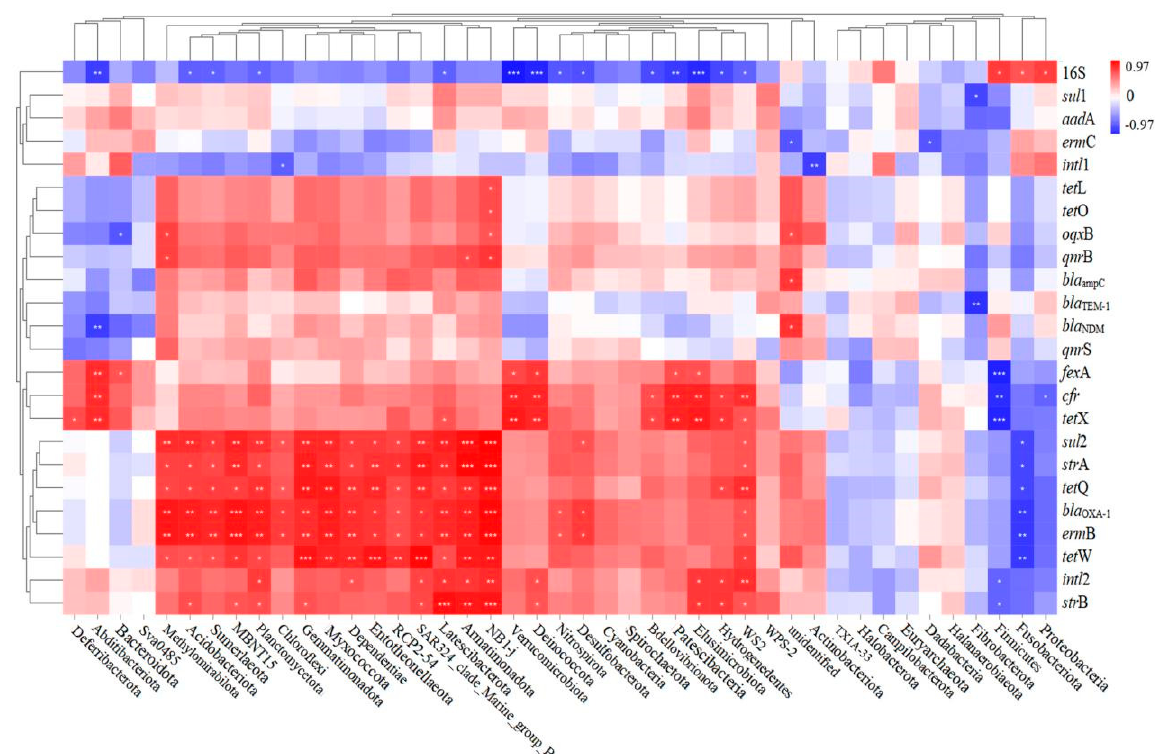
Figure 12. Spearman correlation analysis of target genes (ARG, intl 1, intl 2) with bacterial communities (Phylum levels).